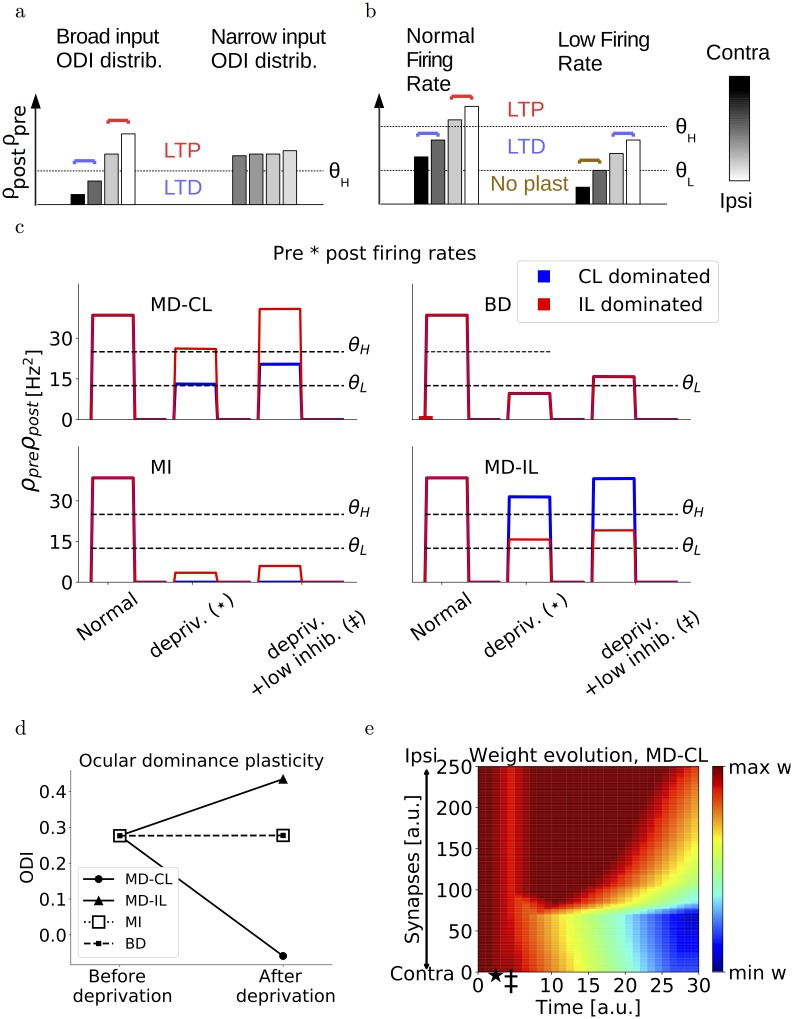
Double-threshold model.(a) Schematic of presynaptic multiplied by postsynaptic firing rates after monocular deprivation, and assuming different ODI distributions of input neurons. If the ODI distribution is too narrow, it is harder for the threshold θ to separate more closed-eye dominated inputs from more open-eye dominated inputs. (b) Schematic of presynaptic multiplied by postsynaptic firing rates after monocular deprivation, and assuming heterogeneous postsynaptic firing. Postsynaptic neurons that receive weaker inputs and fire at lower rates, lead to a depression of open-eye dominated inputs while leaving closed-eye inputs unaltered. These neurons show a counter-intuitive shift towards the closed eye. (c) Examples of the product of presynaptic and postsynaptic firing rates for normally active neurons during MD, BD and MI. For red and blue traces, the product is taken with the most contralaterally dominated and ipsilaterally dominated presynaptic neuron respectively. (d) Ocular dominance index of the postsynaptic neuron at the beginning of the simulation versus the end. The neurons are normally activated. (e) Evolution of synaptic weights over time, in the case of monocular deprivation of the contralateral eye. The star denotes the onset of deprivation, the double dagger denotes the onset of reduced inhibition. Corresponding neuronal activations are shown in panel c.